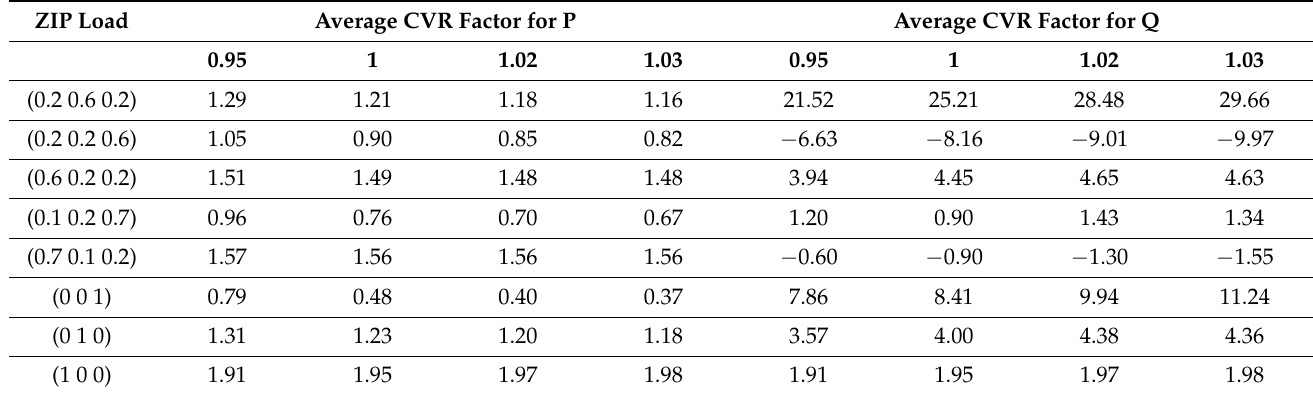
Table 6. Average CVR factor using power captured at substation for case 2.